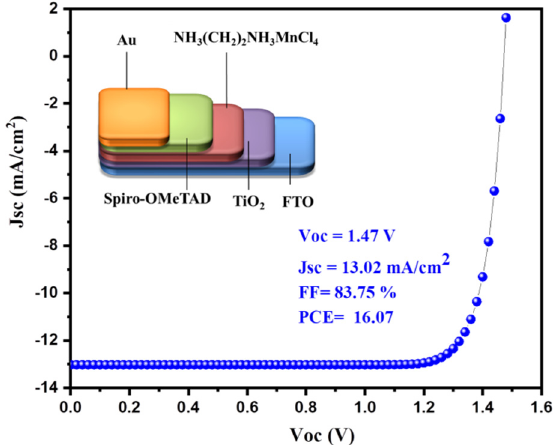
Figure 1. JV graph of FTO/TiO 2 (50 nm)/NH 3 (CH 2 )NH 3 MnCl 4 (250 nm)/Spiro ‐ OMeTAD (300